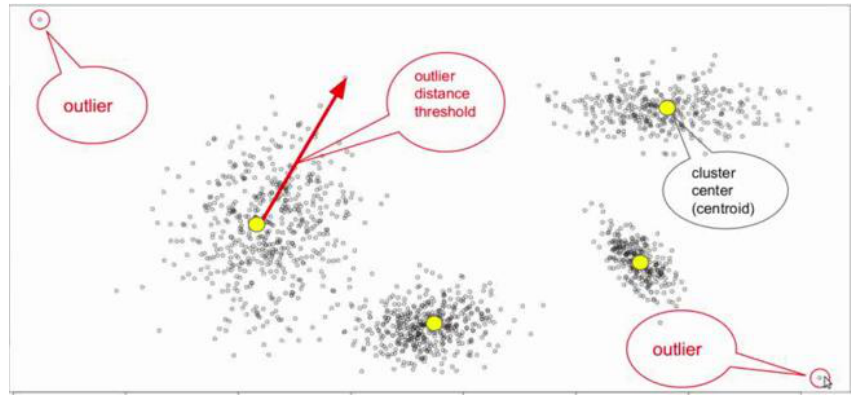
Figure 5—A K-means clustering method to detecte anomalies or